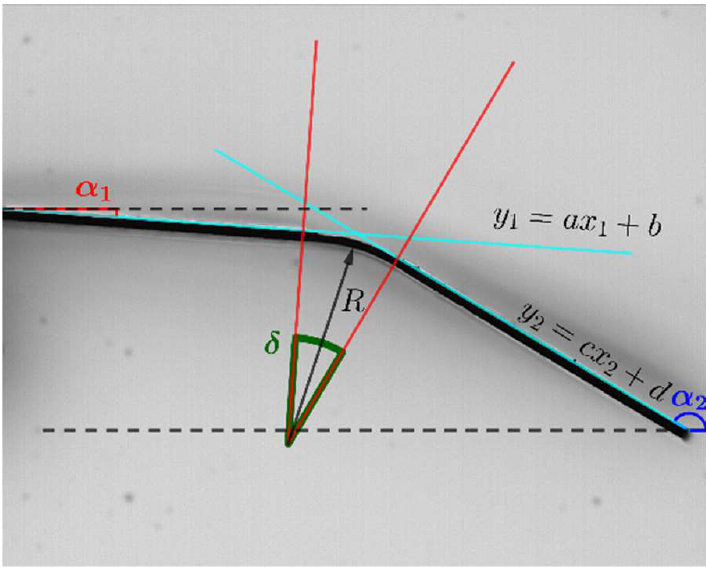
Figure 3. α 1 and α 2 can be obtained through the slopes of the straight lines, and can be used to Figure 3. α (cid:2869) and α (cid:2870) can be obtained through the slopes of the straight lines, and can be used to compute both δ and compute both δ and R .